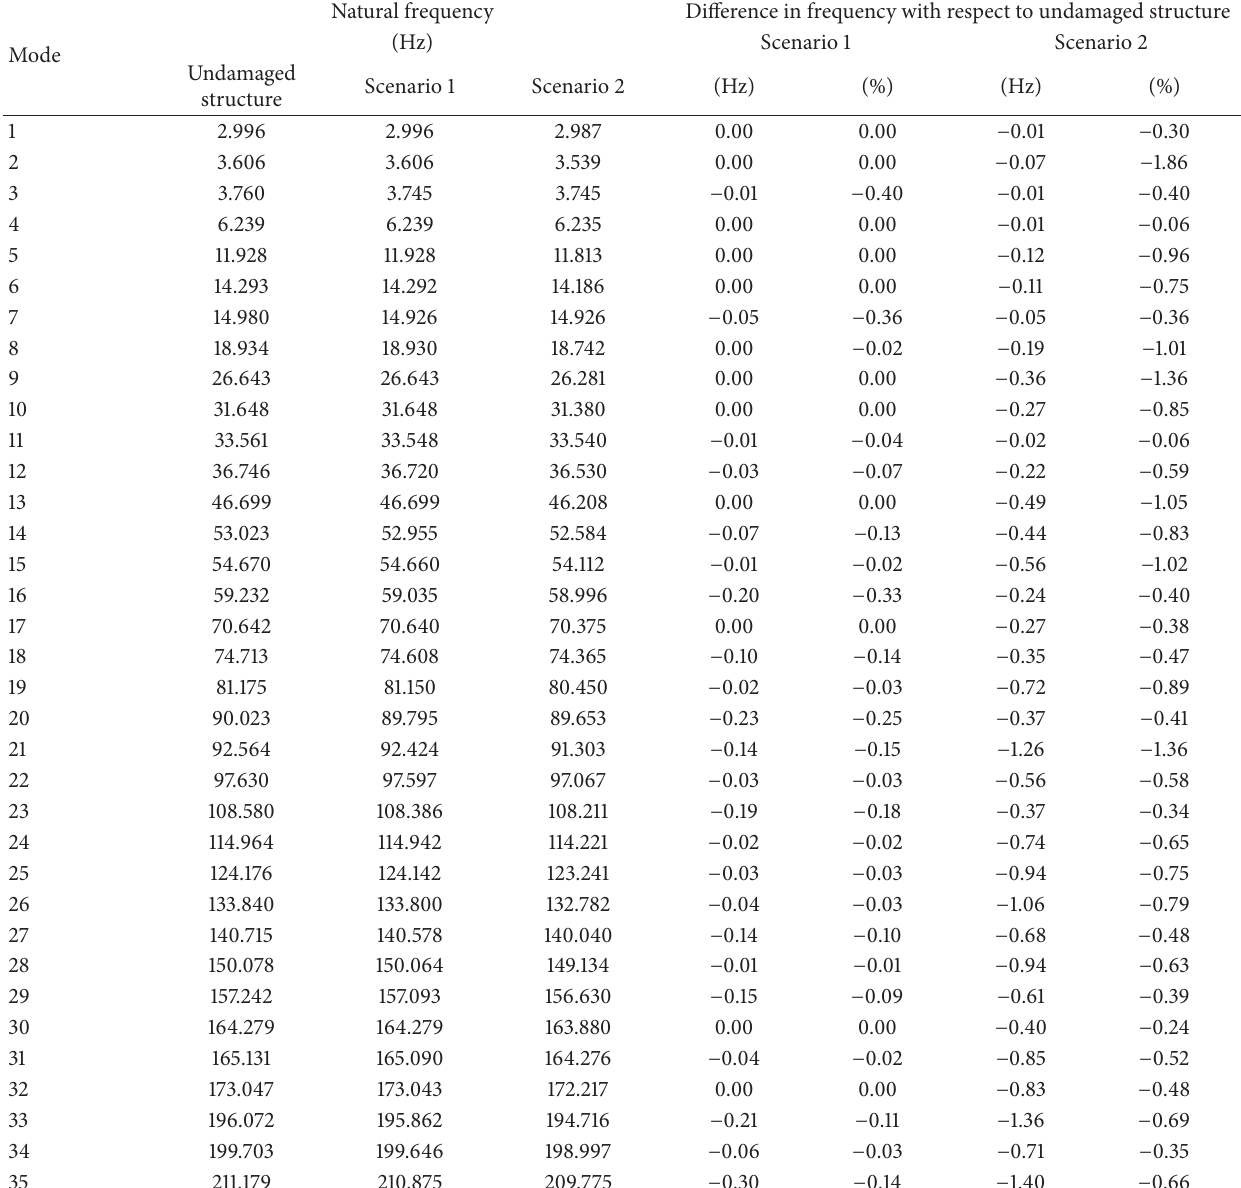
Table 2: First 35 natural frequencies for the undamaged and damaged